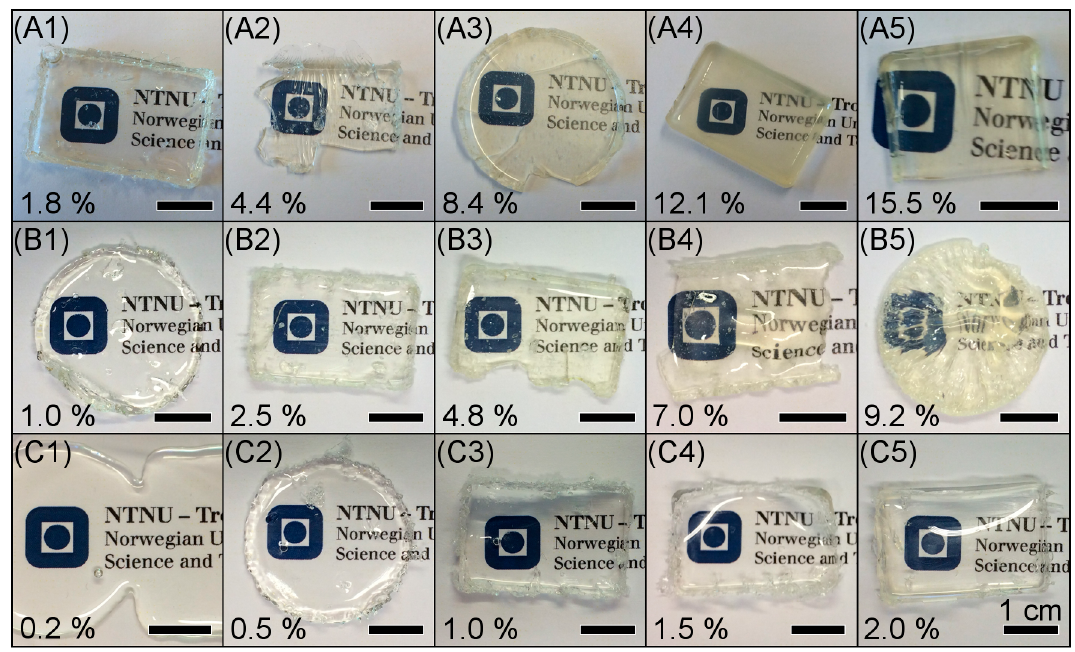
Figure 1. Photographs of mould-casted Ti-PDMS hybrid films prepared using PDMS-OH with viscosities of ( A ) 25 cSt, ( B ) 65 cSt and ( C ) 750 cSt; and TIP/PDMS-OH molar ratios of ( 1 ) 2:1, ( 2 ) 5:1, ( 3 ) 10:1, ( 4 ) 15:1 and ( 5 ) 20:1. The circular and rectangle shaped samples of Ti-PDMS-750-20:1 ( C1 ) had merged. The scale bars are 1 cm for all images and the percentages indicate the volume content of TiO 2 .